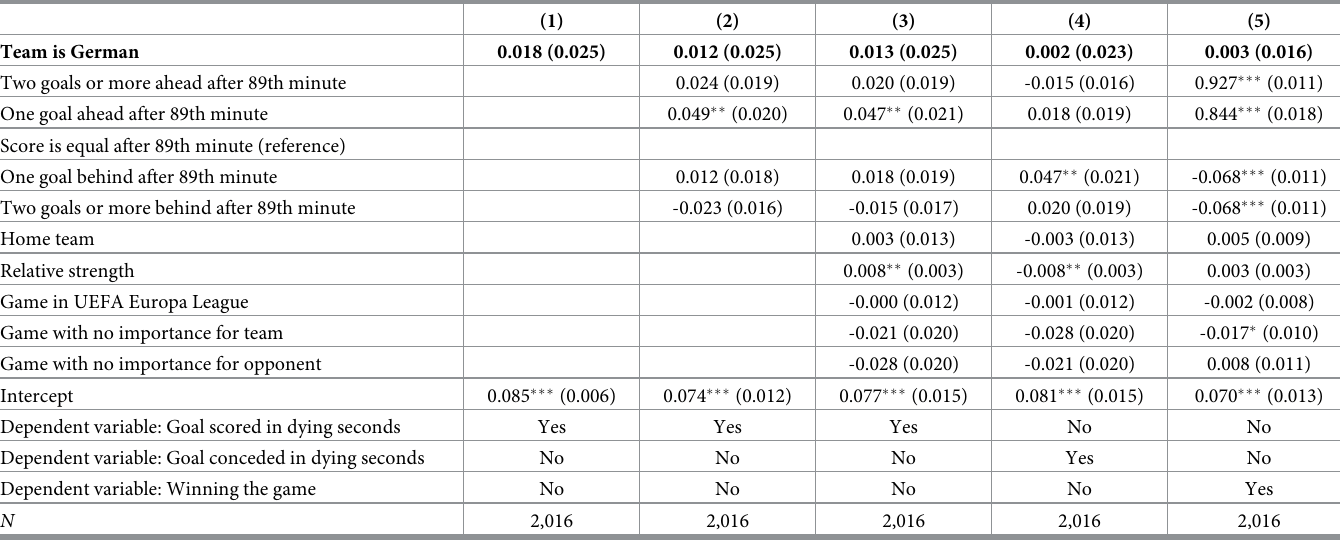
Table 2. Results: Benchmark